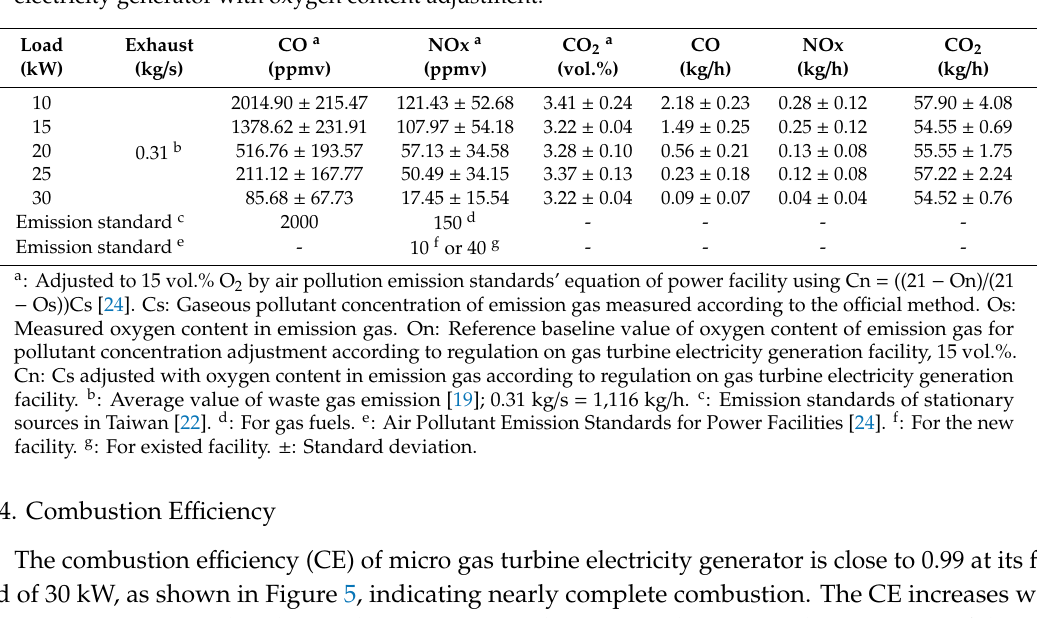
Table 3. Concentrations and mass flow rates of pollutants of exhausted gas from micro gas turbine electricity generator with oxygen content